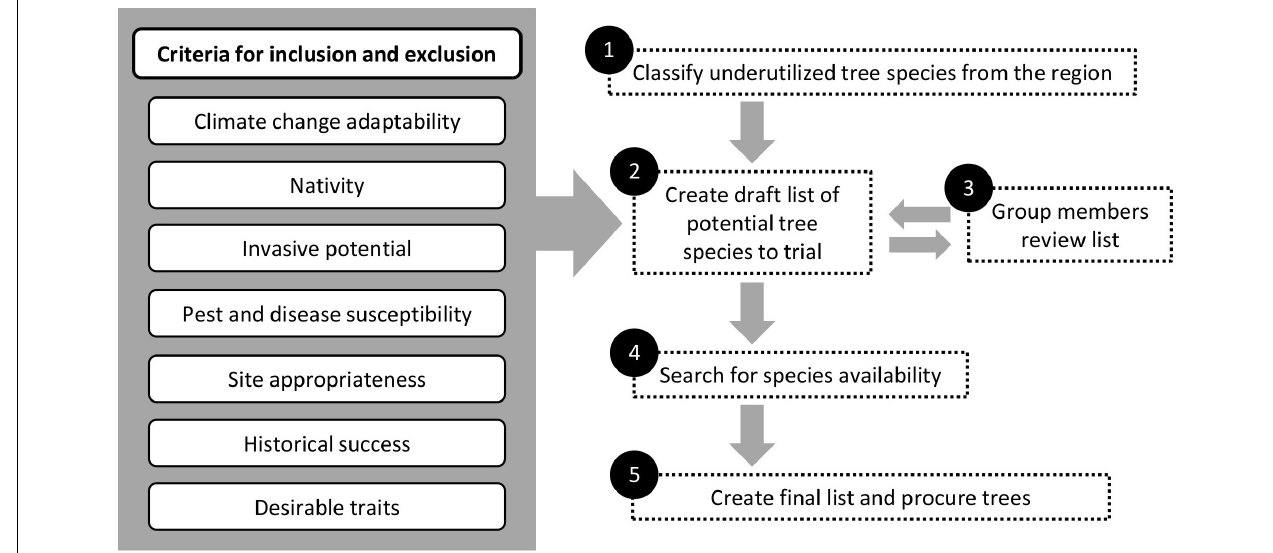
FIGURE 1 | An approach to select underutilized urban tree species for experimental trials through transdisciplinary collaboration. The left panel outlines the criteria a group may consider important for the inclusion or exclusion of particular species. The right panel outlines the process for developing the list of trees to trial. The process is not always linear, as draft lists are revised and reviewed several times during group discussions and emails. Species availability may also influence the final list.